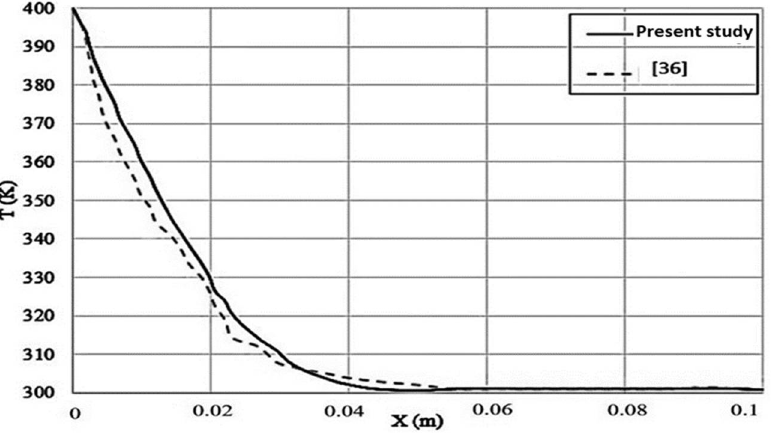
Figure 3. Comparing the results of transient thermal distribution in silica fibers.